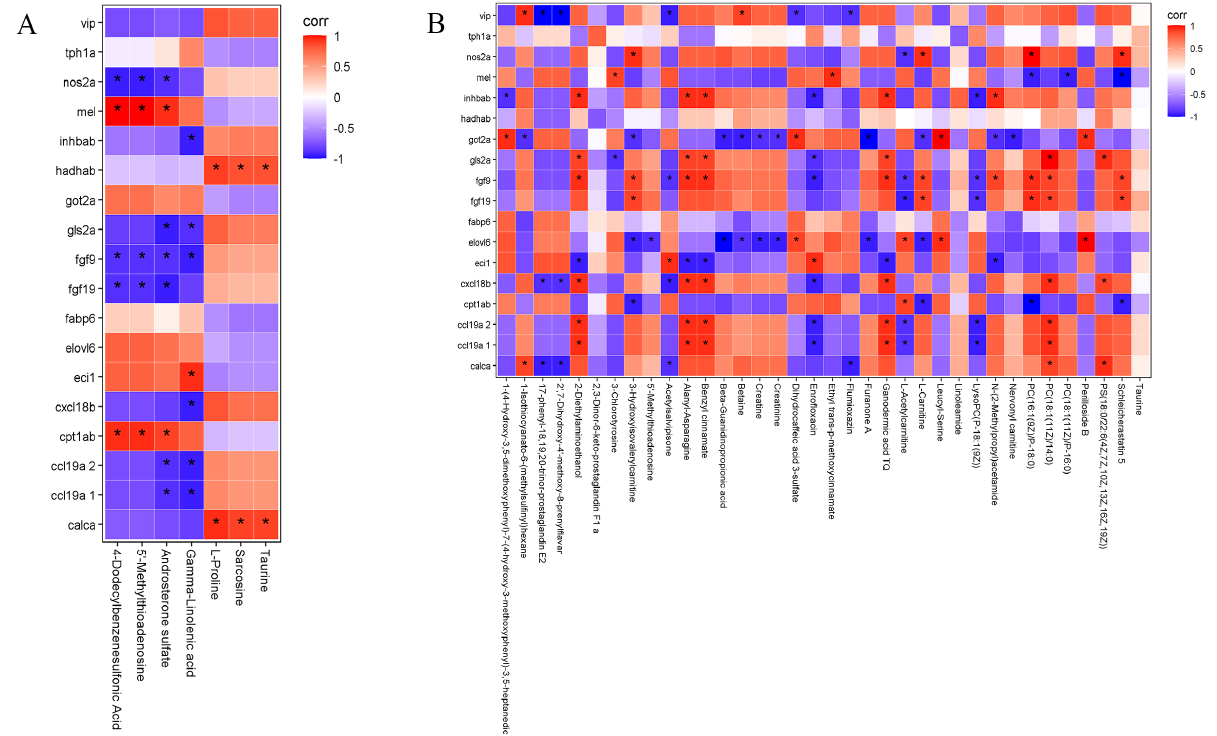
Figure 6. ( A ) Correlation analysis under negative ion mode (NEG). ( B ) Correlation analysis under positive ion mode (POS). Note: red—positive correlation; blue—negative correlation; “*”— p < 0.05; dark colors represent strong correlations and light colors represent weak correlations.